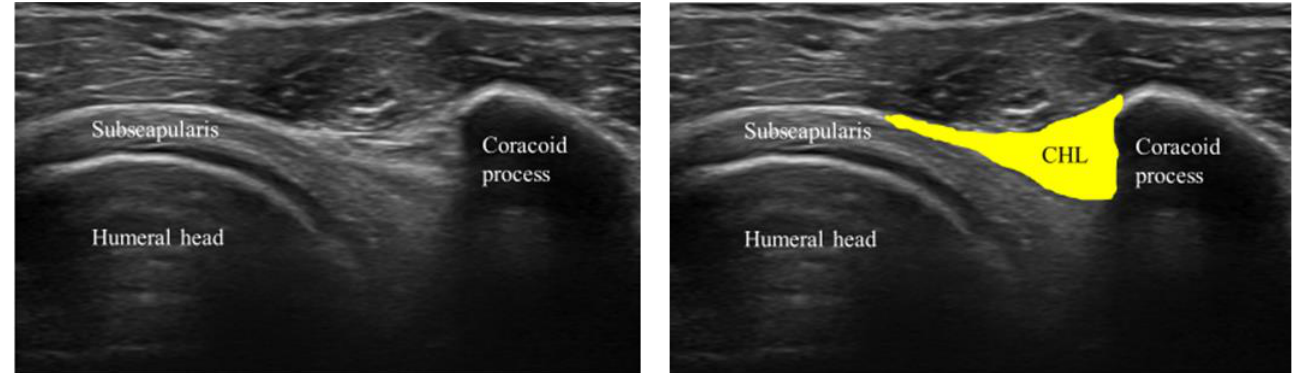
Figure 2. The triangular-in-shape hyperechoic structure located between the subscapularis tendon, the coracoid process, and the deltoid muscle was defined as the CHL in the present study.